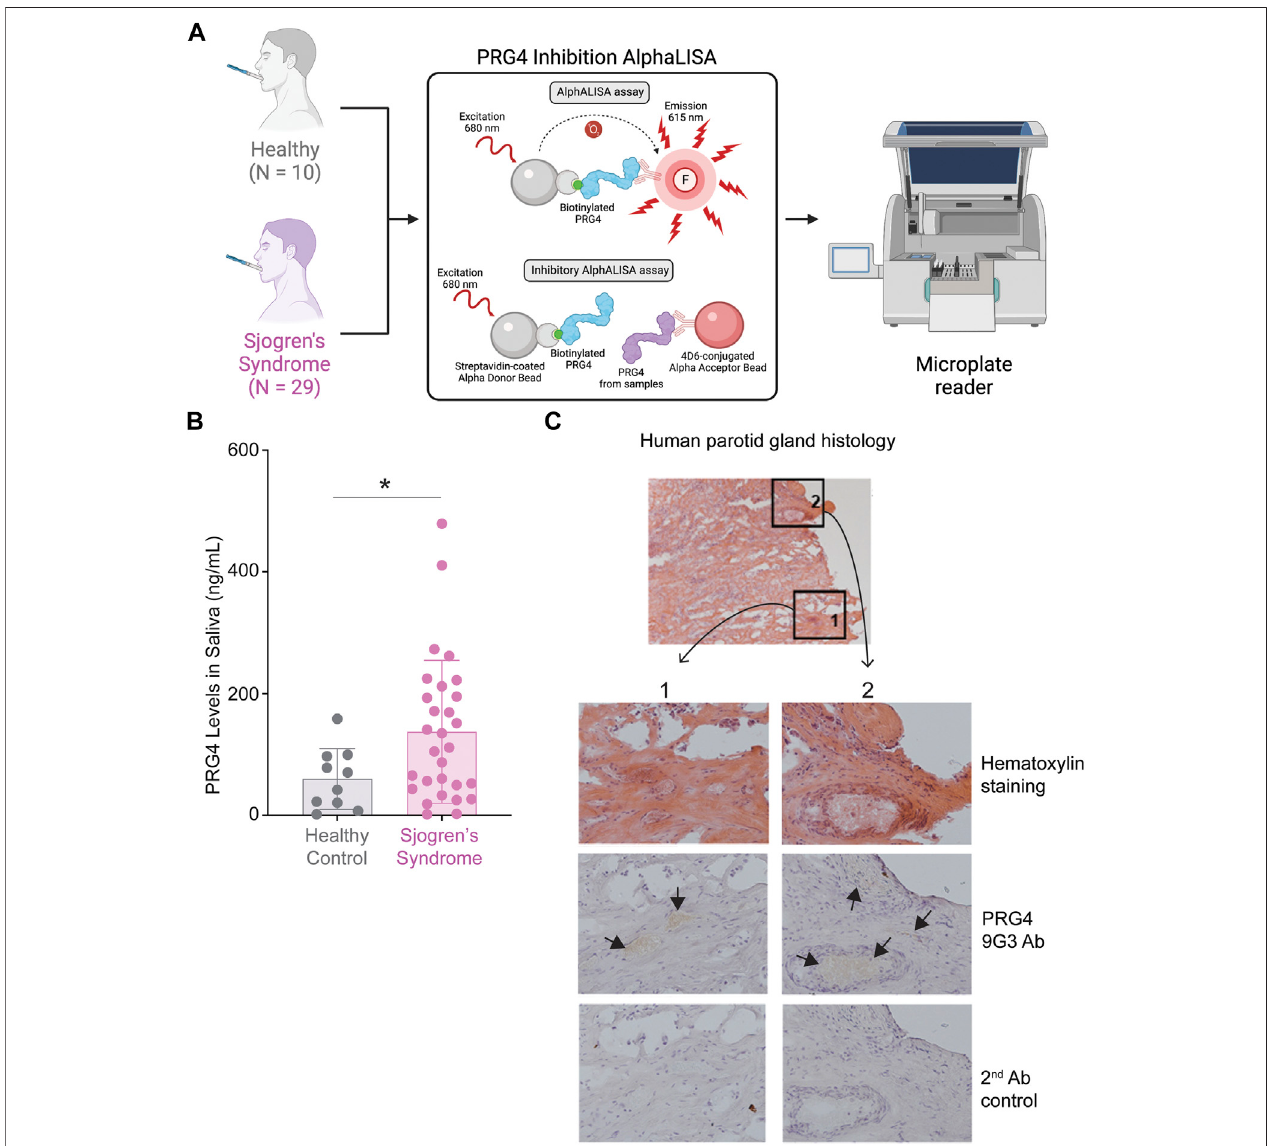
FIGURE 6 | increase of PRG4 in Saliva and Parotid Gland. (A) AlphALISA work fl ow using a designed PRG4 antibody 4D6-based assay. (B) PRG4 levels were measured. Dataare represented asbar graphswith ± standard deviation(SD) and analyzed byaWelch ’ s two-tailed paired t test: * p > 0.05, ** p > 0.01. (C) Parotid gland histology using hematoxylin staining and a PRG4 antibody (9G3). As a control, secondary antibody control was used without the addition of a primary PRG4 antibody.